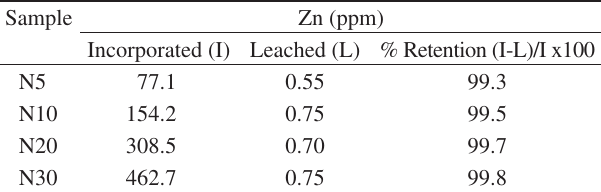
Table 7. Leached Zn content of the 60 days hydrated samples